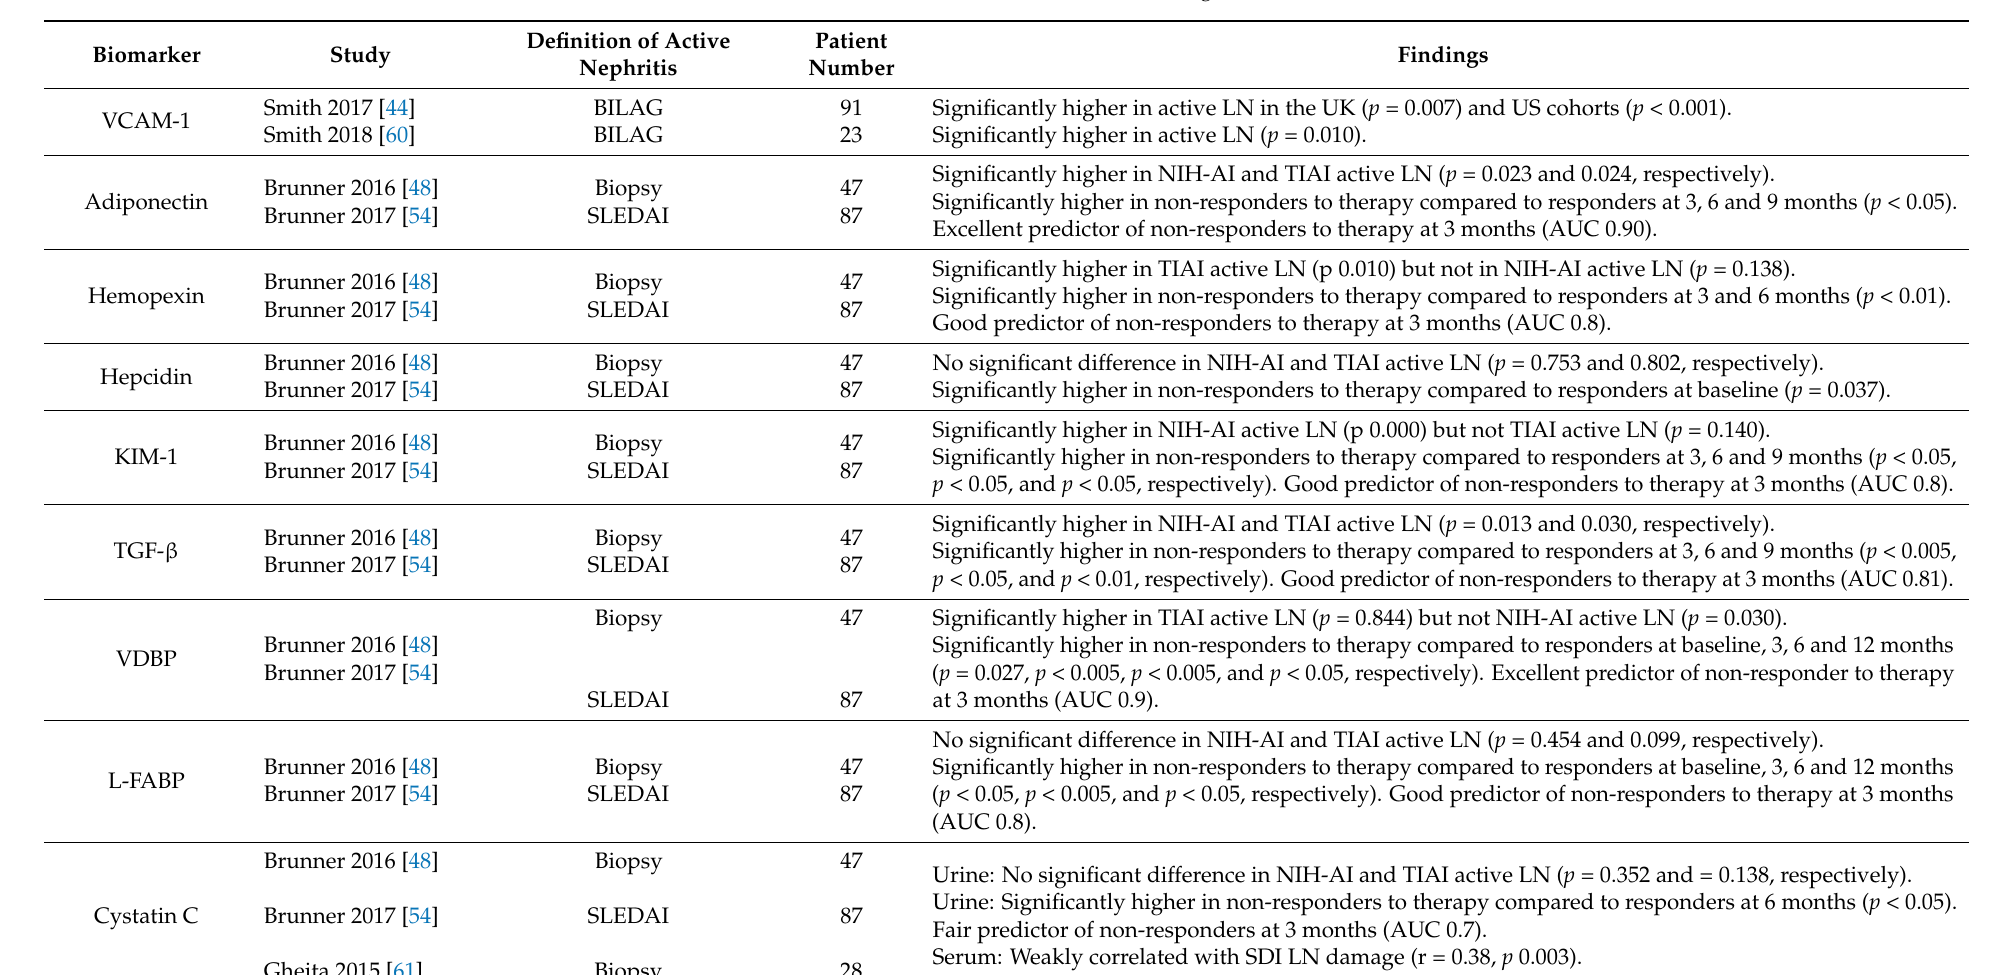
Table 3. Other novel renal biomarkers investigated.